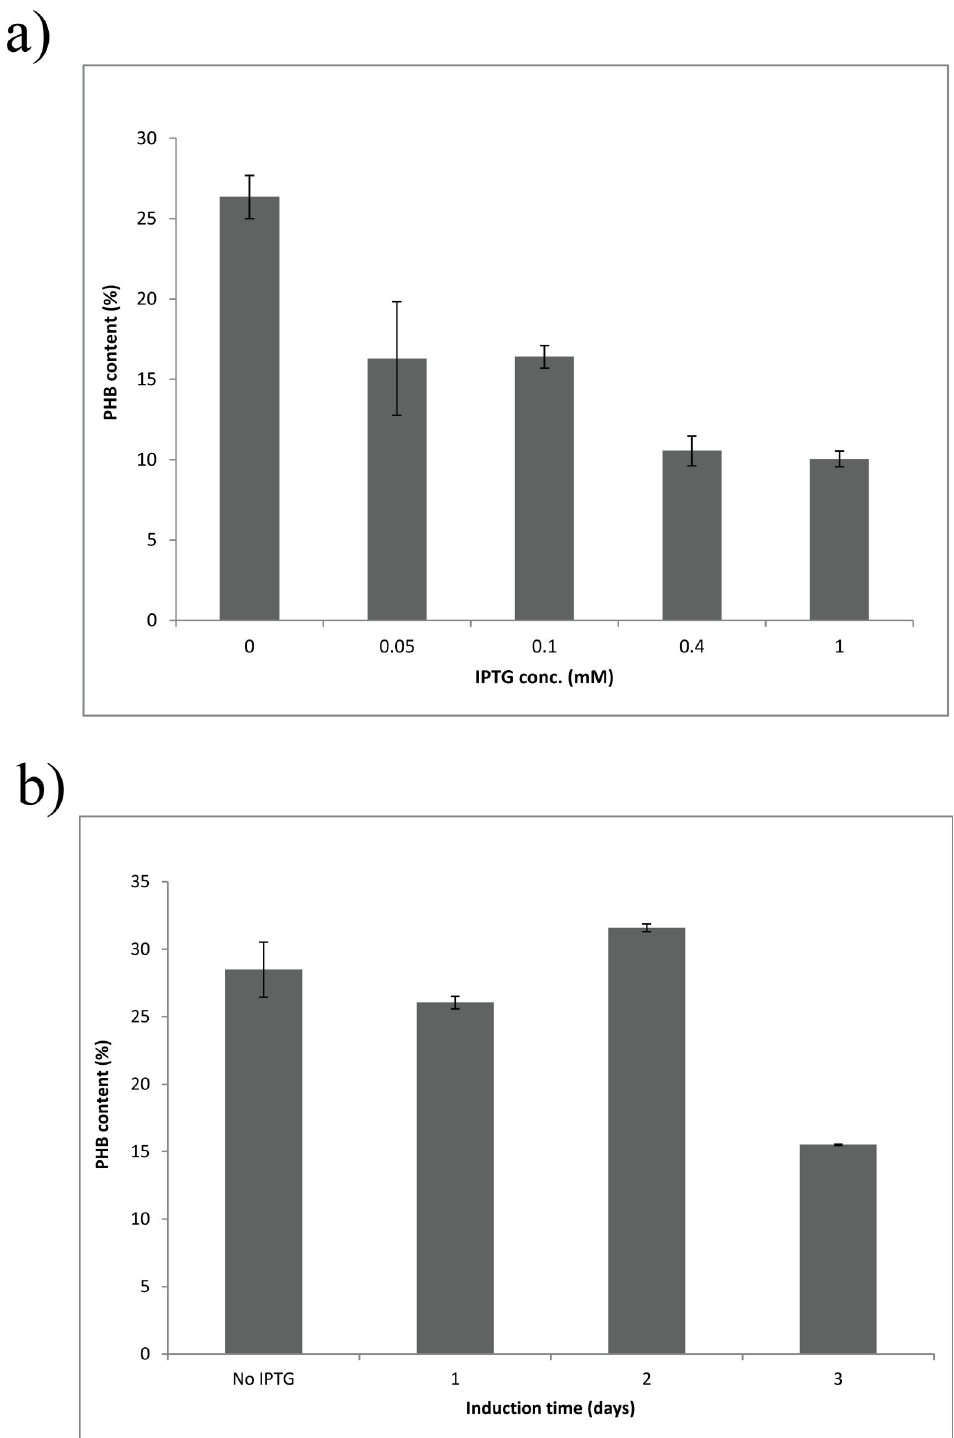
Fig 5. PHB content produced by strain SmUW256 induced at different concentrations of IPTG (a) and induced at 0.4 mM IPTG at different points in time for 3 day incubation (b). The experiment was performed in duplicate. Results are presented as mean ± standard deviation (SD). Error bars indicate